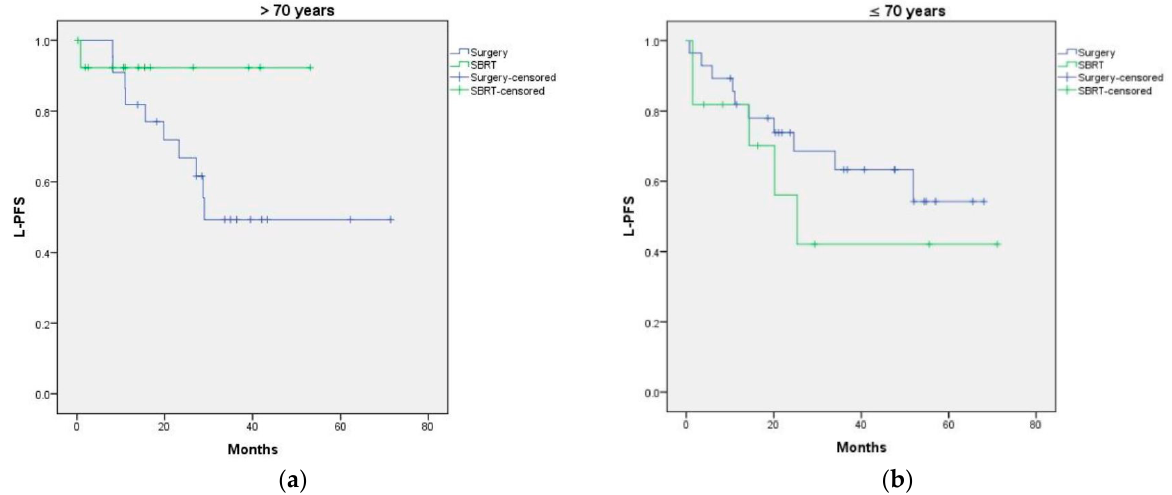
Figure A1. Impact of age on L-PFS. p = 0.73.